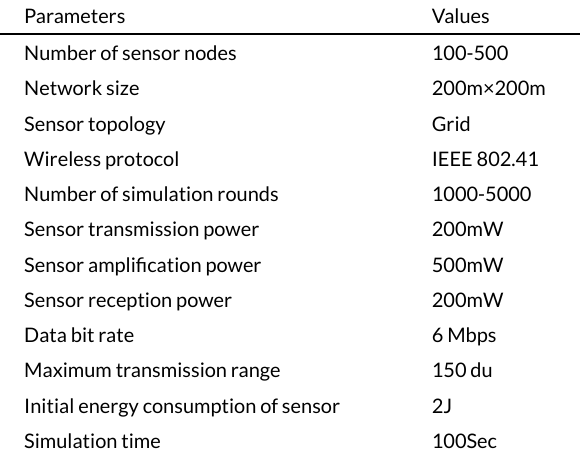
Table 2. Simulation